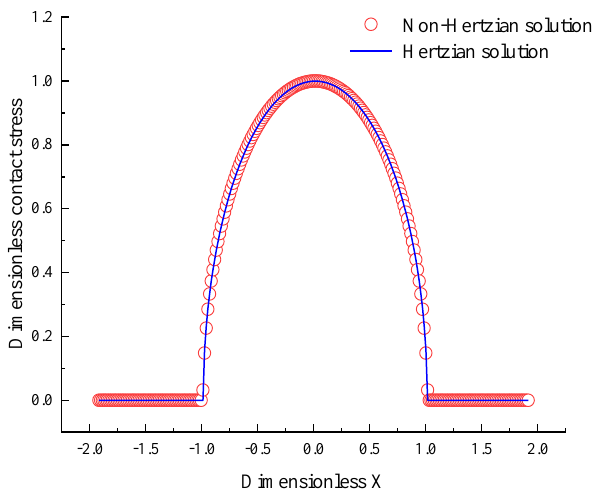
Figure 3. A comparison of the non-Hertzian and Hertzian solutions for the contact stress distribution between the ball and the screw raceway. The viscosity flow behavior of the lubricant film between the ball and raceway can be described by the Reynolds equation shown in Figure 4b. The initial film contact stress distribution in the Reynolds equation is the non-Hertzian contact stress distribution, which can further observe the variation of the elastohydrodynamic lubrication characteristics.